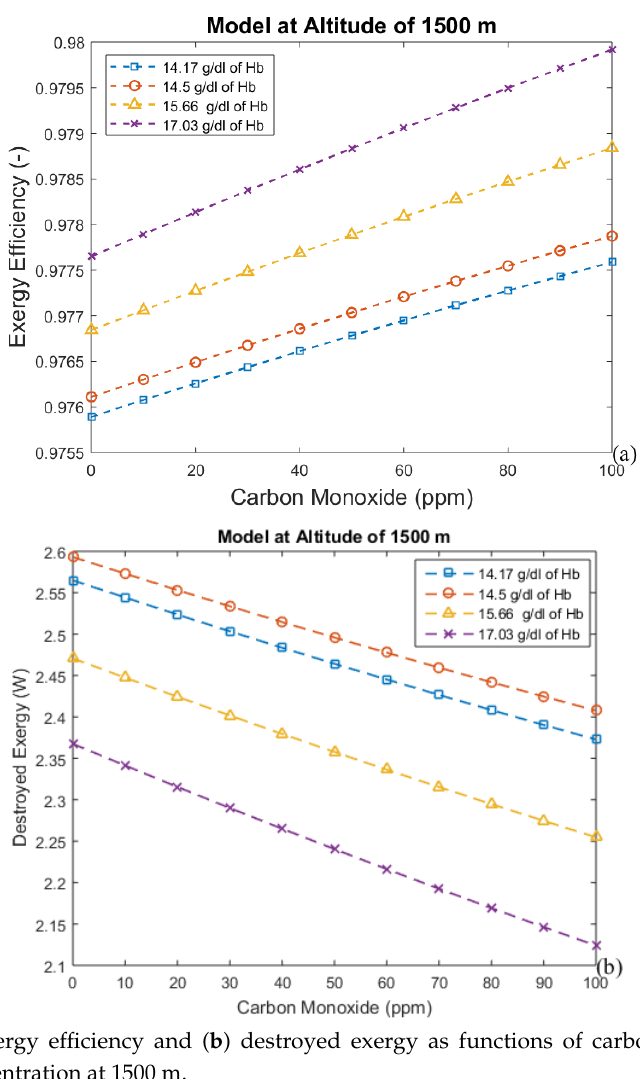
Figure 4. ( a ) Exergy efficiency and ( b ) destroyed exergy as functions of carbon monoxide and hemoglobin (Hb) concentration at sea level.